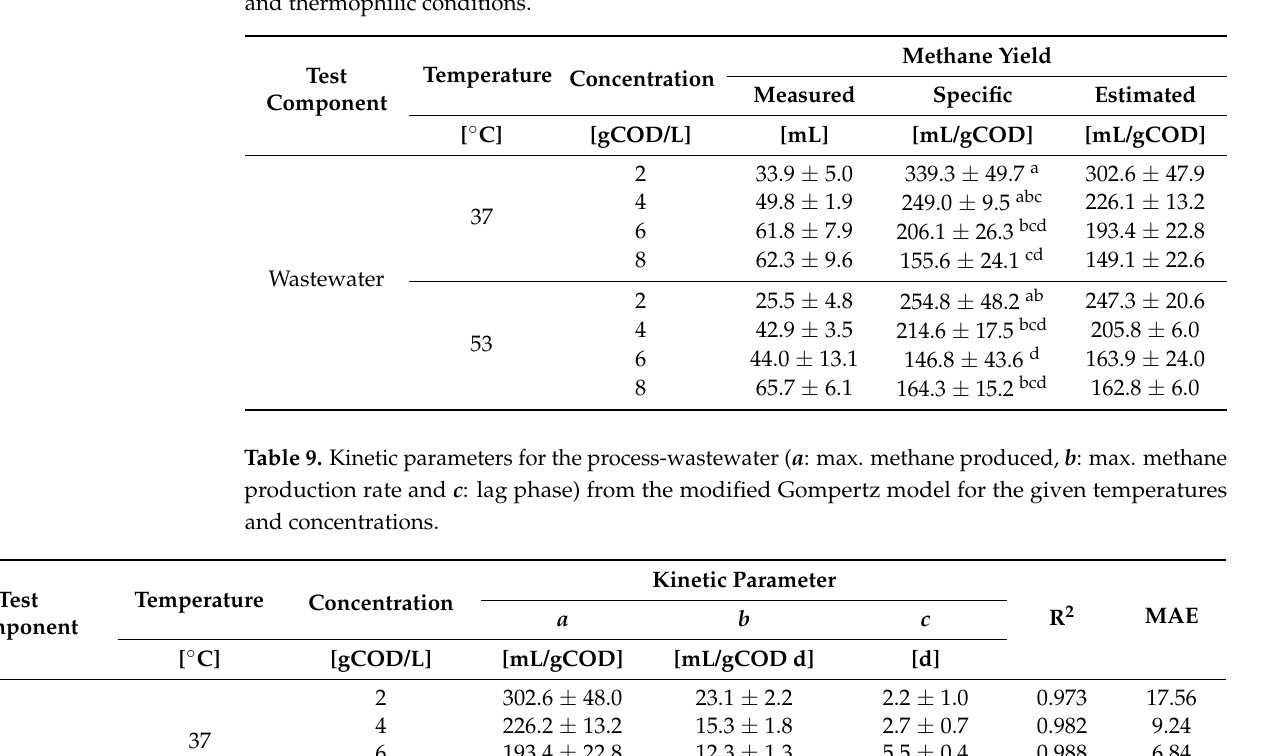
Table 8. Mean methane yields for given concentrations of the process-wastewater under mesophilic and thermophilic conditions.